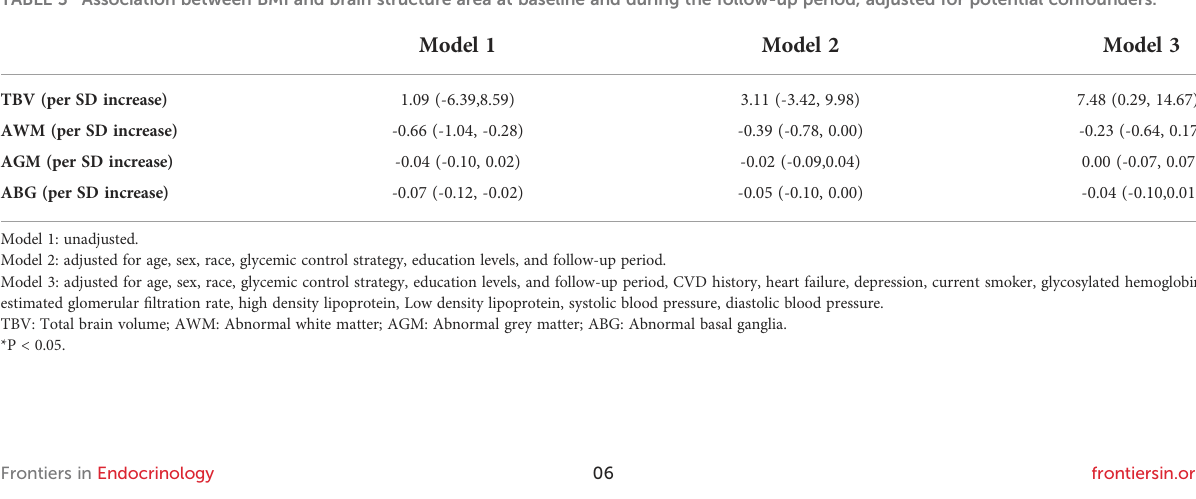
TABLE 3 Association between BMI and brain structure area at baseline and during the follow-up period, adjusted for potential